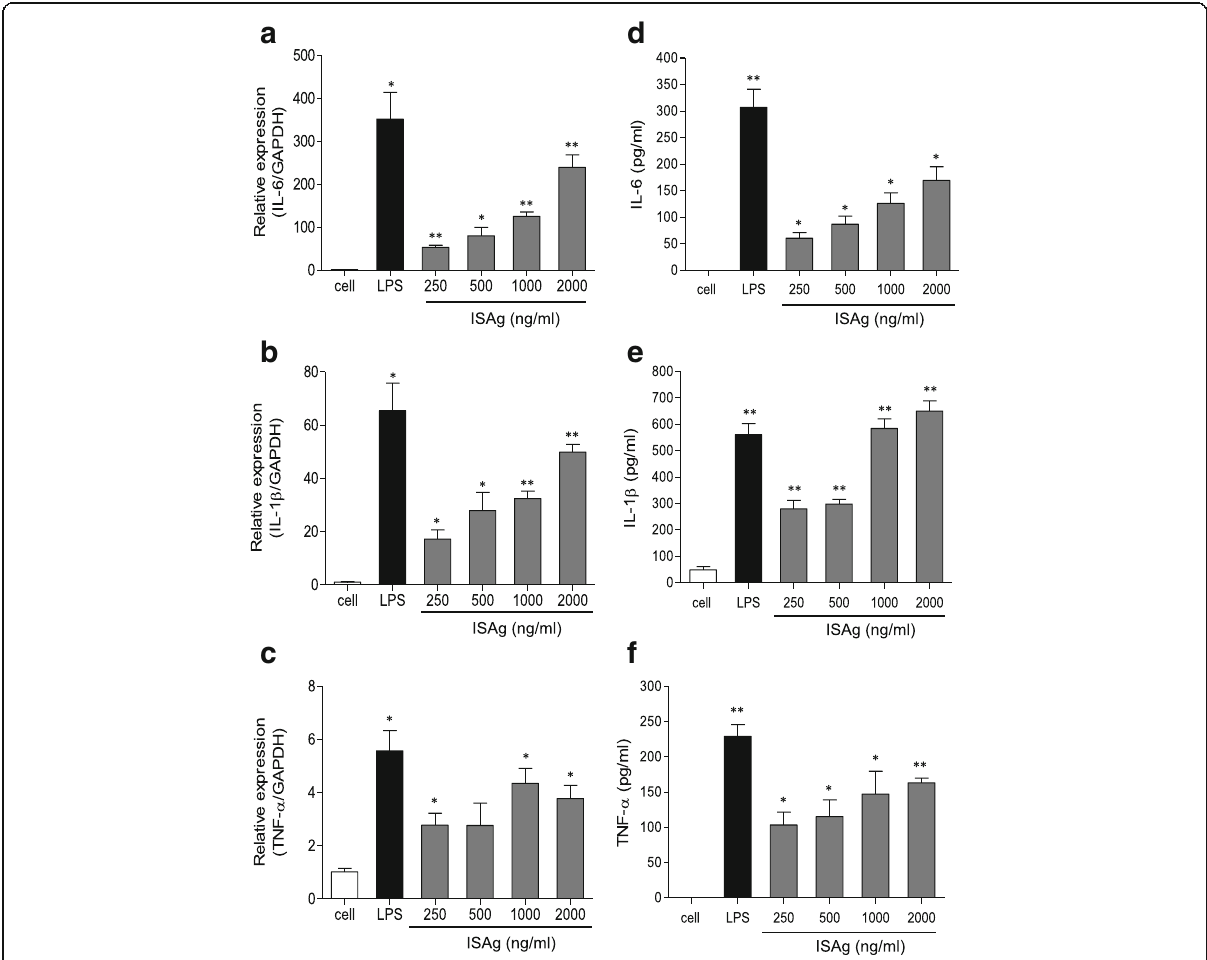
Fig. 2 ISAg treatment induced secretion of immuno-stimulatory cytokines from macrophages. a – c RAW264.7 cells were treated with LPS or indicated concentrations of ISAg. Gene expression levels of ( a ) IL-6, ( b ) IL-1 β , and ( c ) TNF- α relative to GAPDH were compared using qRT-PCR. d – f The levels of each protein secreted in the culture medium were quantified using an ELISA kit. The mean±standard deviation values are presented (n=3 per group; Student ’ s t-test; * P <0.05, ** P